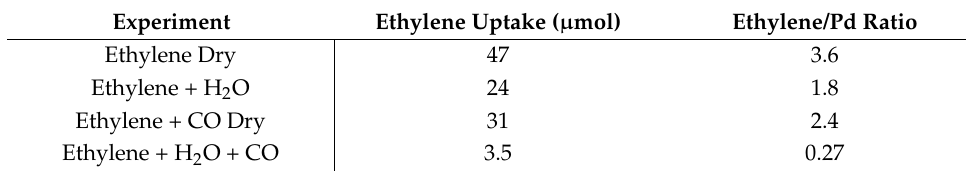
Figure 2. Ethylene uptake over 1% Pd/BEA with and without CO co-feed in wet and dry conditions. Adsorption begins at T = 50 s. (200 ppm ethylene, 0 or 500 ppm CO, 0 or 6% H 2 O, 12% O 2 , balance N 2 ). Table 1. Ethylene uptake and ethylene/Pd ratio for each experiment.